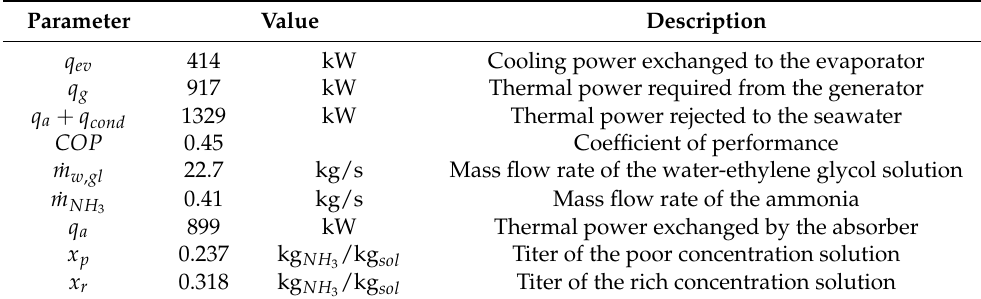
Table 2. Major outcomes of the design of the ARC (CHILL).